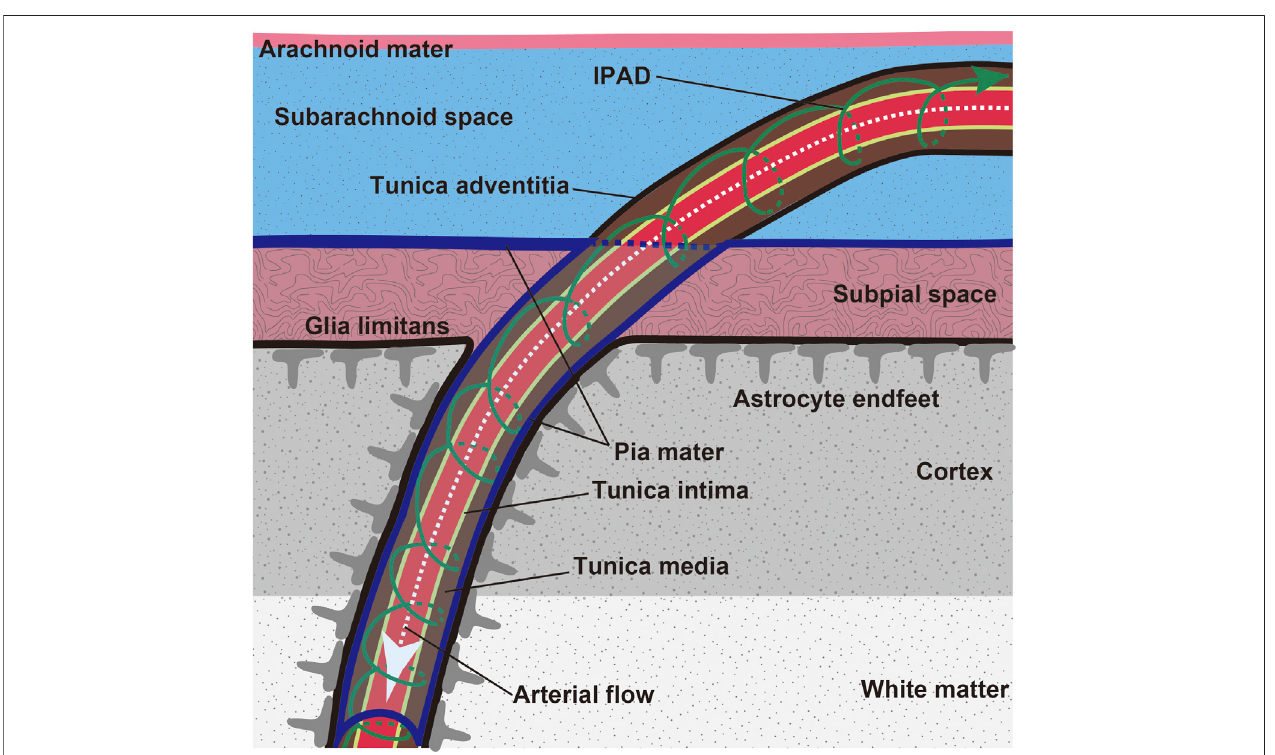
FIGURE 2 | Scheme of leptomeninges and penetration of leptomeningeal artery into the brain parenchyma. Brain waste is cleared through the IPAD route (green arrow). A β is preferentially deposited in the tunica media of the leptomeningeal and cortical arteries in CAA.